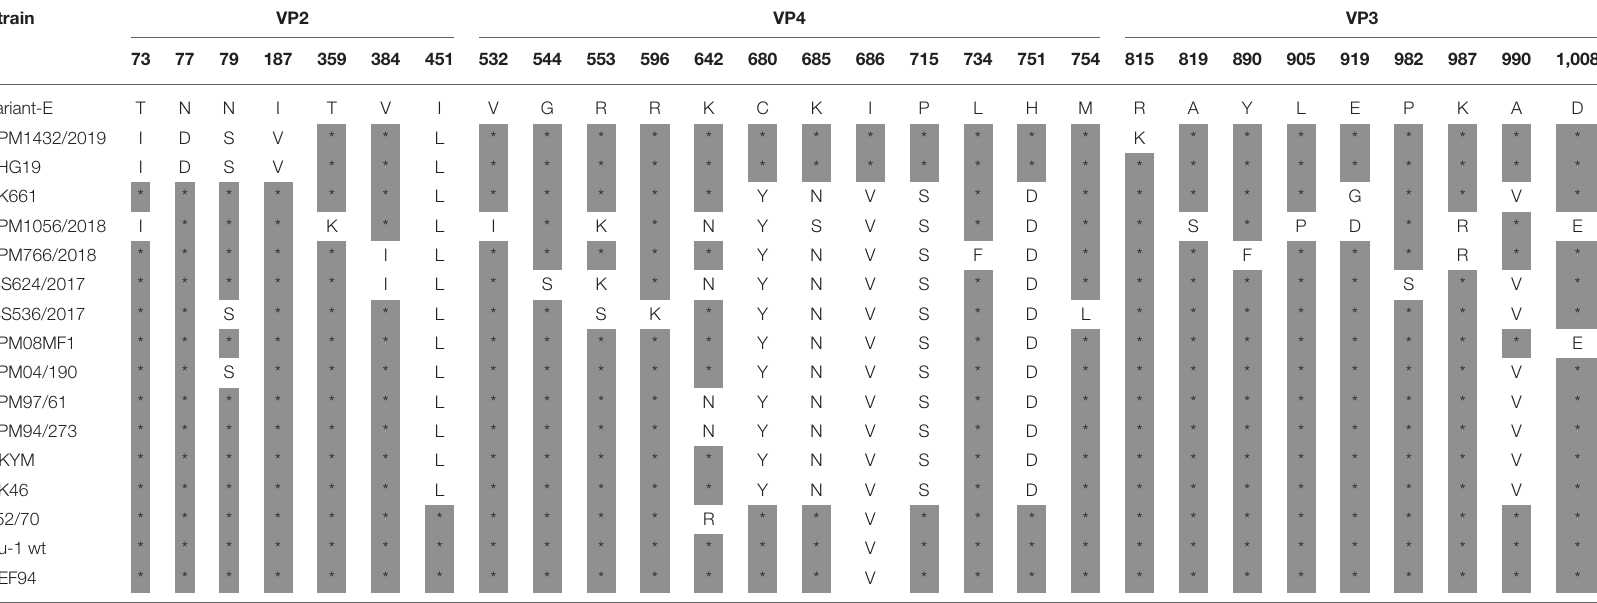
The gray area with asterisk indicate aa position identical to the reference strain, Variant